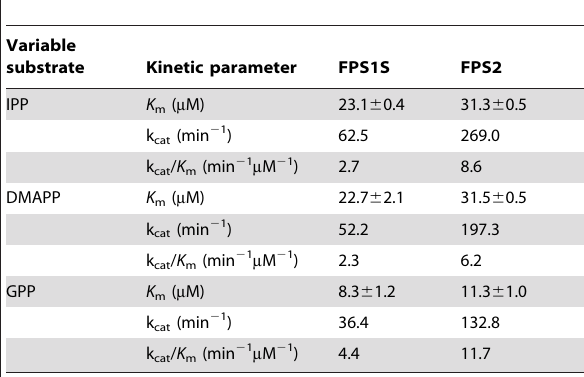
Table 1. Steady-state kinetic constants for FPS1S and FPS2.